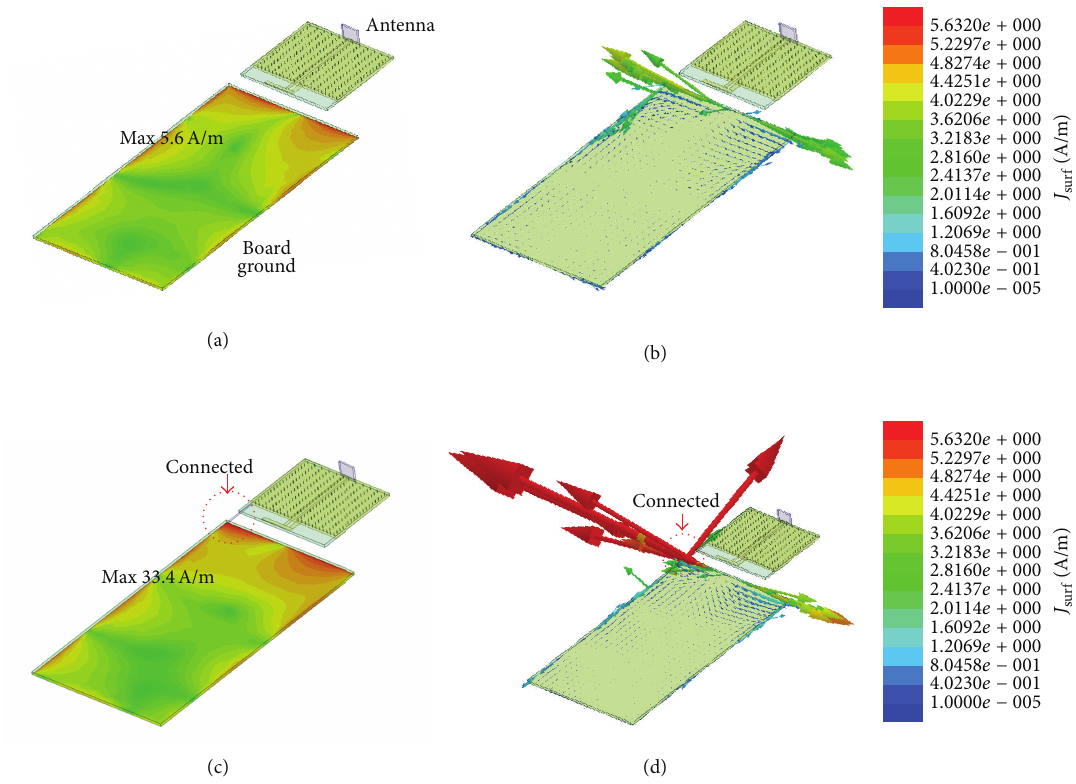
Figure 7: Induced current distribution on the ground plane without transmission lines (a) with separate ground (b) current vectors with separate ground (c) with common ground (d) current vectors with common ground.